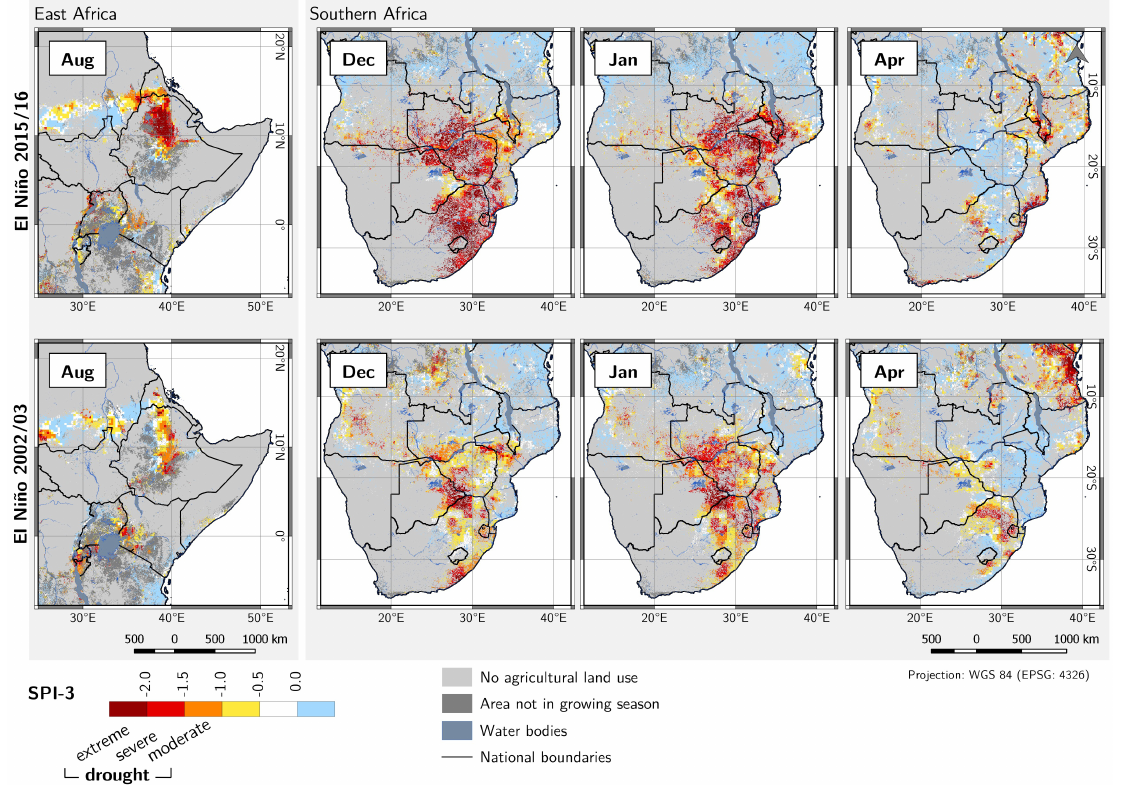
Figure 8. Drought dynamics based on monthly SPI-3 during El Niño events 2015/2016 (strong) and 2002/2003 (moderate) for August (Aug.), December (Dec.), January (Jan.) and April (Apr.) in East and southern